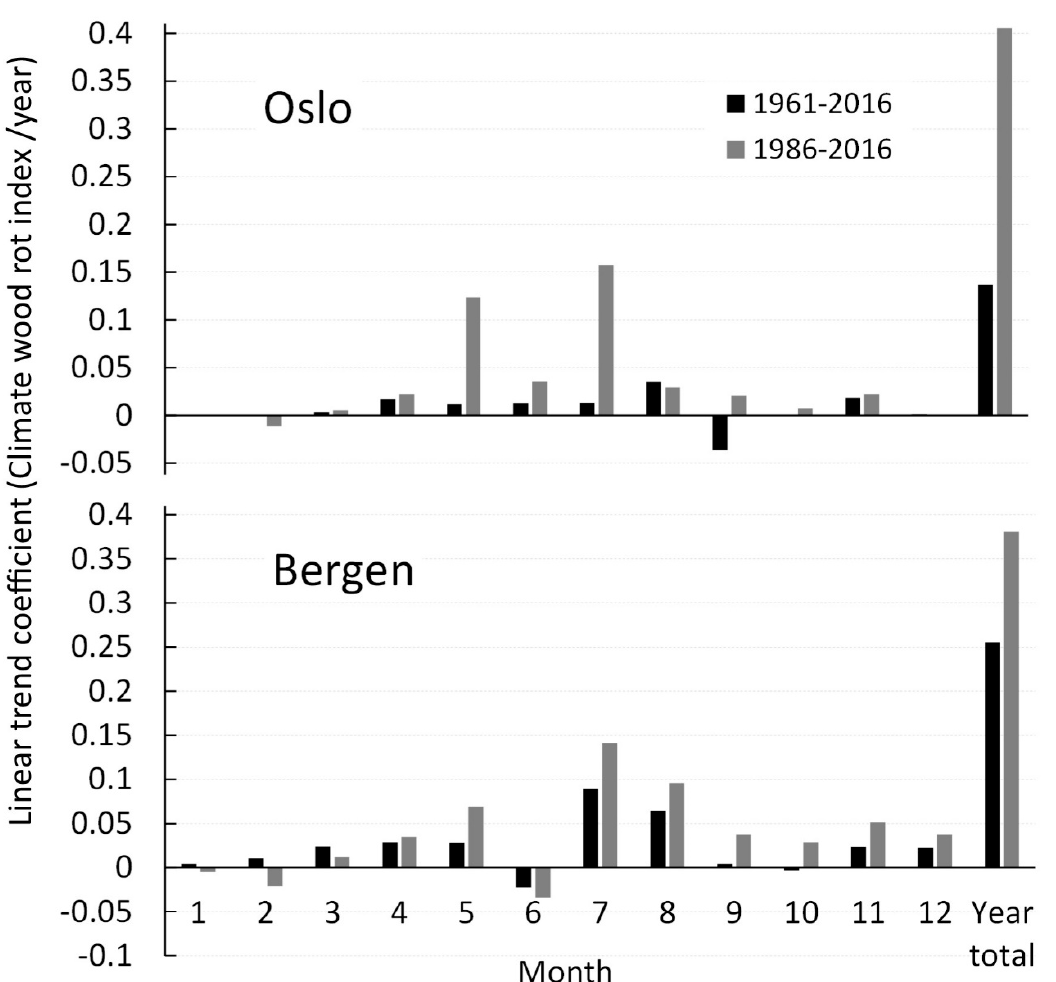
Figure 5. The linear trend coefficient values for the monthly and yearly climate index from 1961 and 1986 through to September 2016 in Oslo and Bergen.